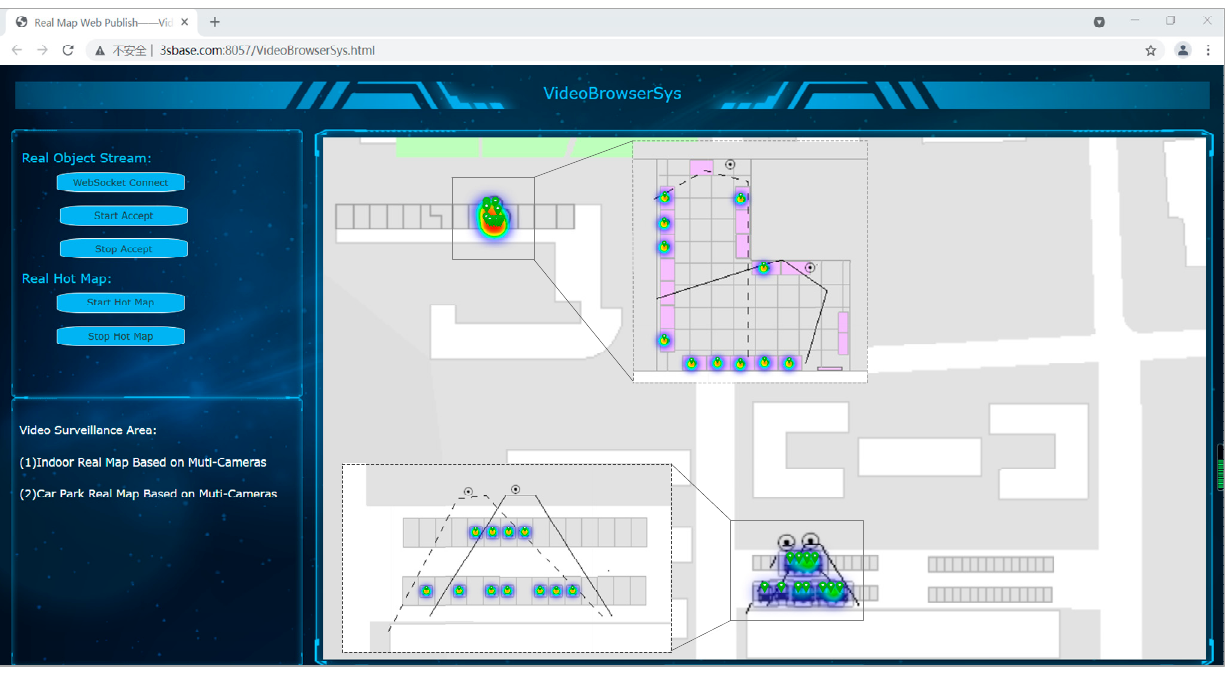
Figure 15. The main interface of VideoBrowserSys.